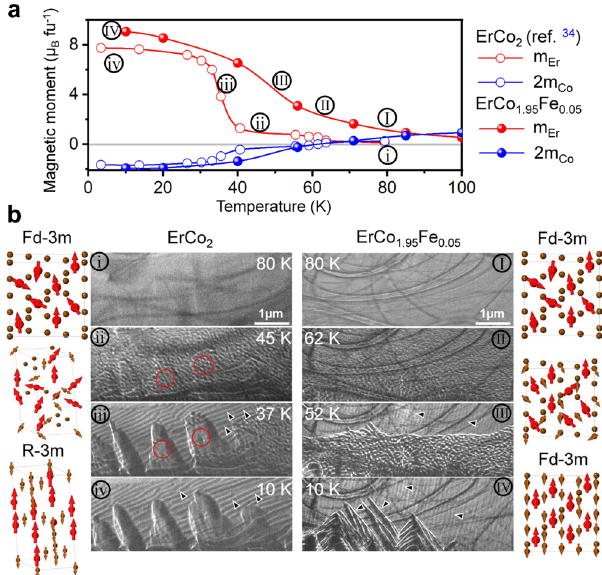
Fig. 5 Magnetism and magnetic structure for ErCo 2 -based alloys. a Temperature-dependent magnetic moments for Er (red) and Co (blue) in ErCo 2 34 , and ErCo 1.95 Fe 0.05 alloys. b Magnetic domain evolution in ErCo 2 - based alloys examined using cryogenic Lorentz microscopy in the Fresnel mode. The black arrow heads show the magnetic domains and red circles illustrate the mountain-like contrasts caused by strain; the crystal structure change upon transition is also shown by a unit cell (red and brown spheres for Er and Co atoms, respectively, and red and brown arrows for the magnetic moments of Er and Co, respectively).